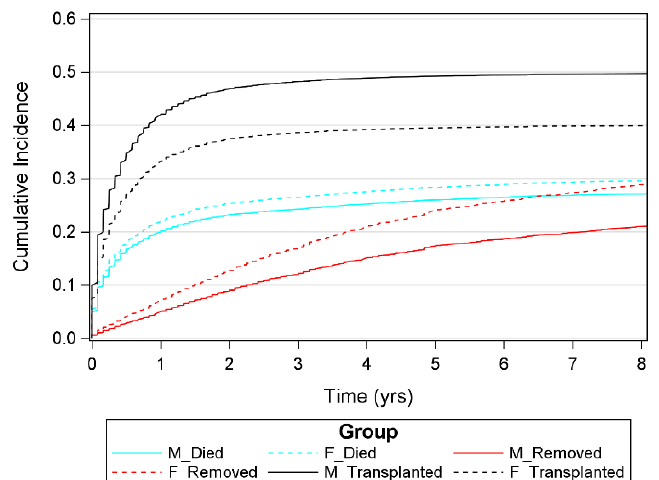
Figure 5. Cumulative incidence per year for males (M) and females (F) and the three outcomes examined (died while on waiting list, removed from waiting list and transplanted).